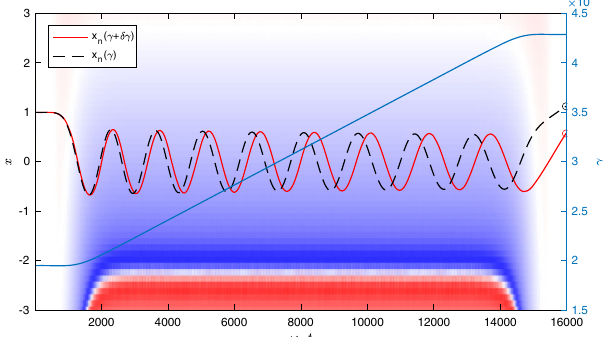
FIG. 6. Representative particle track through fields taken from the 3D simulation. The design (normalized) energy is initially γ ¼ 19 500 , and it is accelerated to γ ¼ 42 891 , as indicated by the blue curve. The particle undergoes betatron oscillations indicated by the red and black dashed curves. The red curve shows the track for a beam δγ from the design energy, with δγ ¼ 1950 . The black and red circled dots at the end show the result of a calculation from the initial coordinates using the combined matrix M . Colorscale is the accelerating field (see Fig.